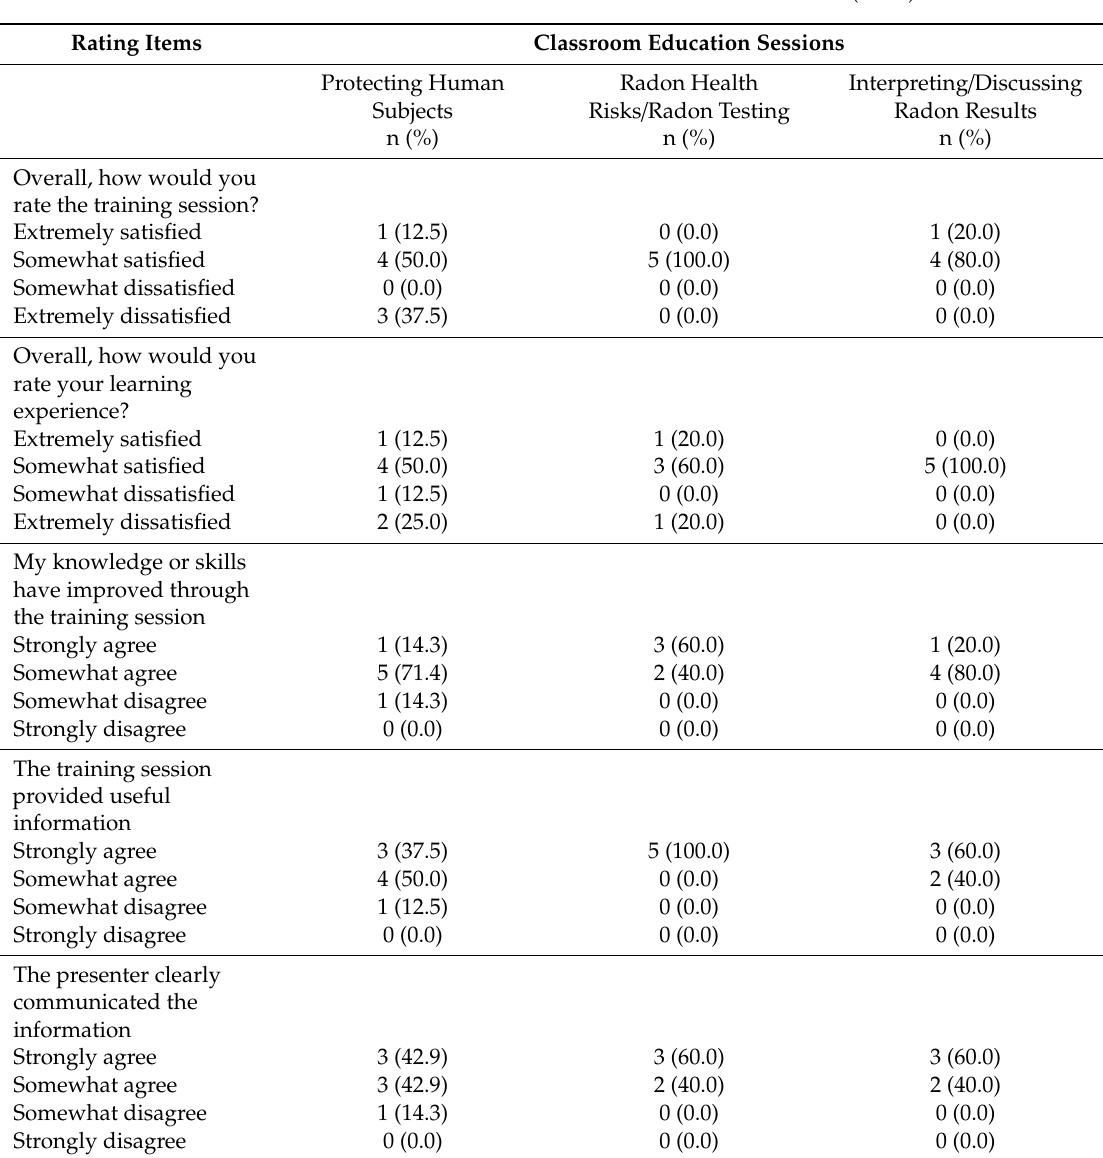
Table 3. Ohio Student Evaluations of the Three Classroom Sessions ( n =